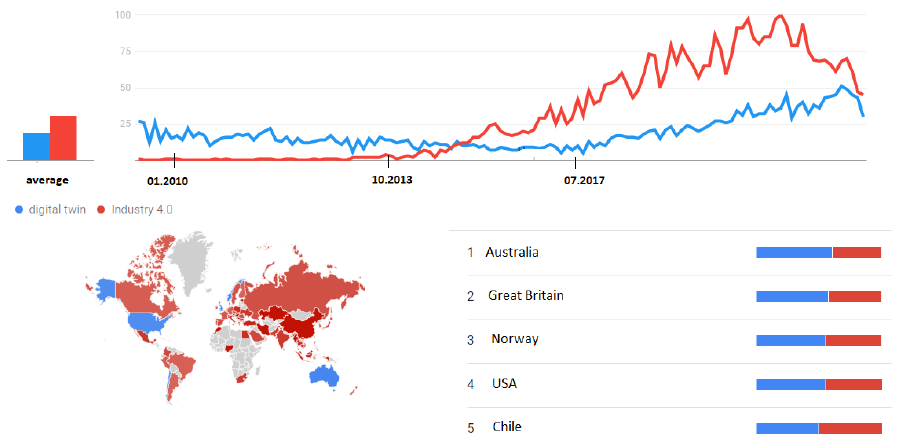
Figure 6. Trends in interest in the terms “Industry 4.0” (red line) and “digital twin” (blue line) (concerns the period from 1 Jan 2010–12 Jan 2021).